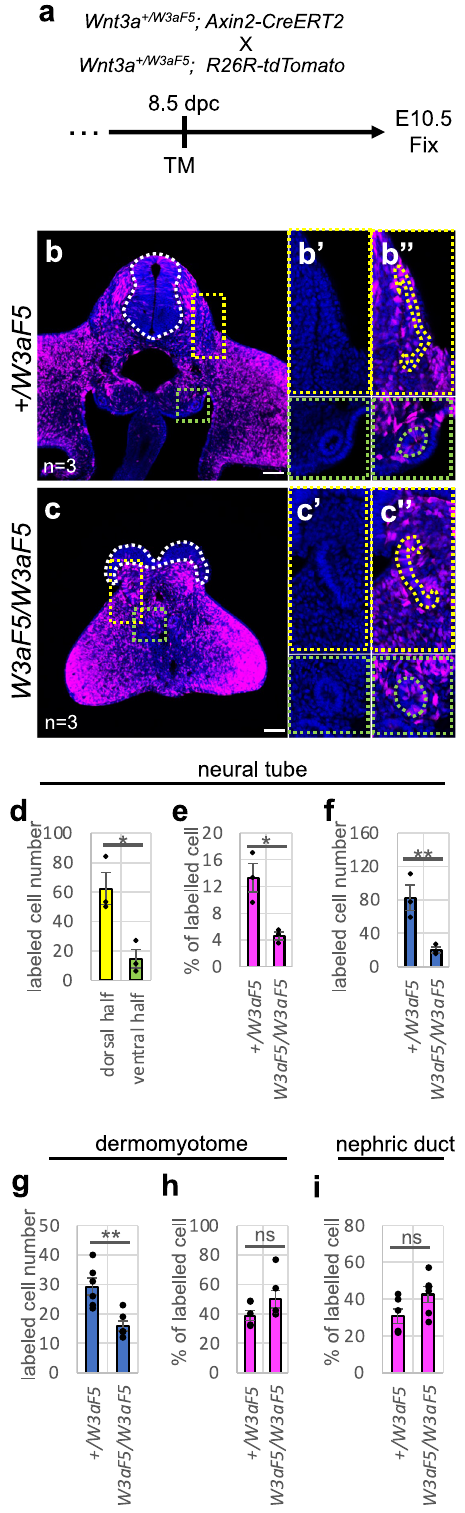
positive cells was pronounced in both medial (region 1) and lateral (region 2) epiblast regions of Wnt3a-Fzd5 homozygous embryos at E8.75 (Fig. 5a – f). Considering that lack of paracrine activity can lead to heterogeneity in Wnt signaling between adjacent cells, we focused on the top 10% of cells with strong Wnt signaling to examine the extent to which cells with strong Wnt signaling affect Wnt signaling in sur- rounding cells. Actually, the heterogeneity of Wnt signaling between neighboring cells, de fi ned as variation index, was signi fi cantly